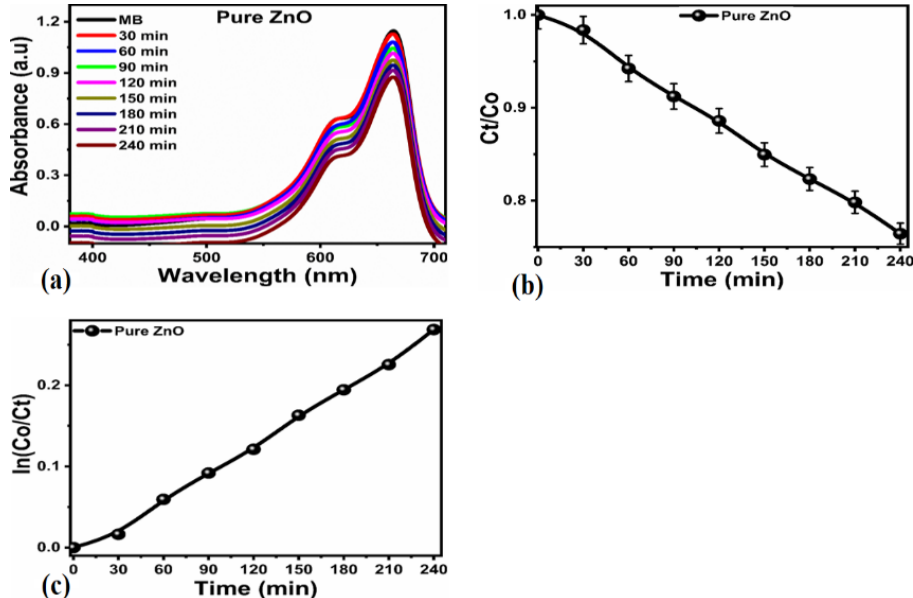
Figure 4. Degradation over time (240 min) of a solution of MB of concentration 1.87 × 10 −5 M under irradiation with UV light in the presence of 5 mg of pristine ZnO. ( a ) UV-vis absorption spectra during dye degradation, ( b ) kinetics C t / C o irradiation time, ( c ) Ln C t / C o plot of pure ZnO over MB.